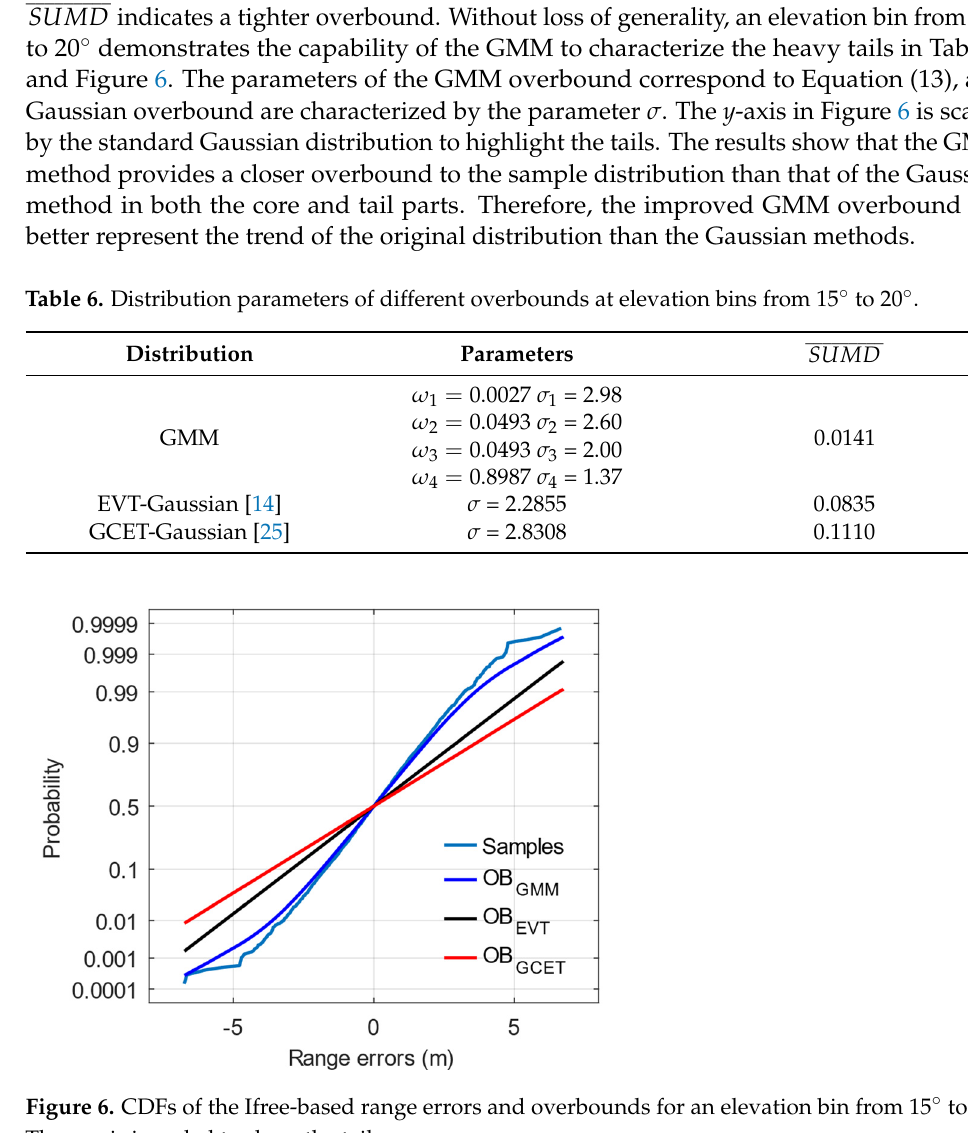
Figure 7. Motion trajectory of the land vehicle.